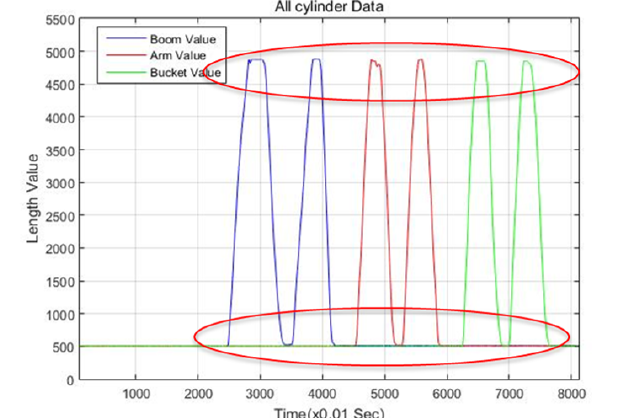
Figure 8. The graph showing the wire sensor’s output data of the maximum and minimum cylinder length related to each